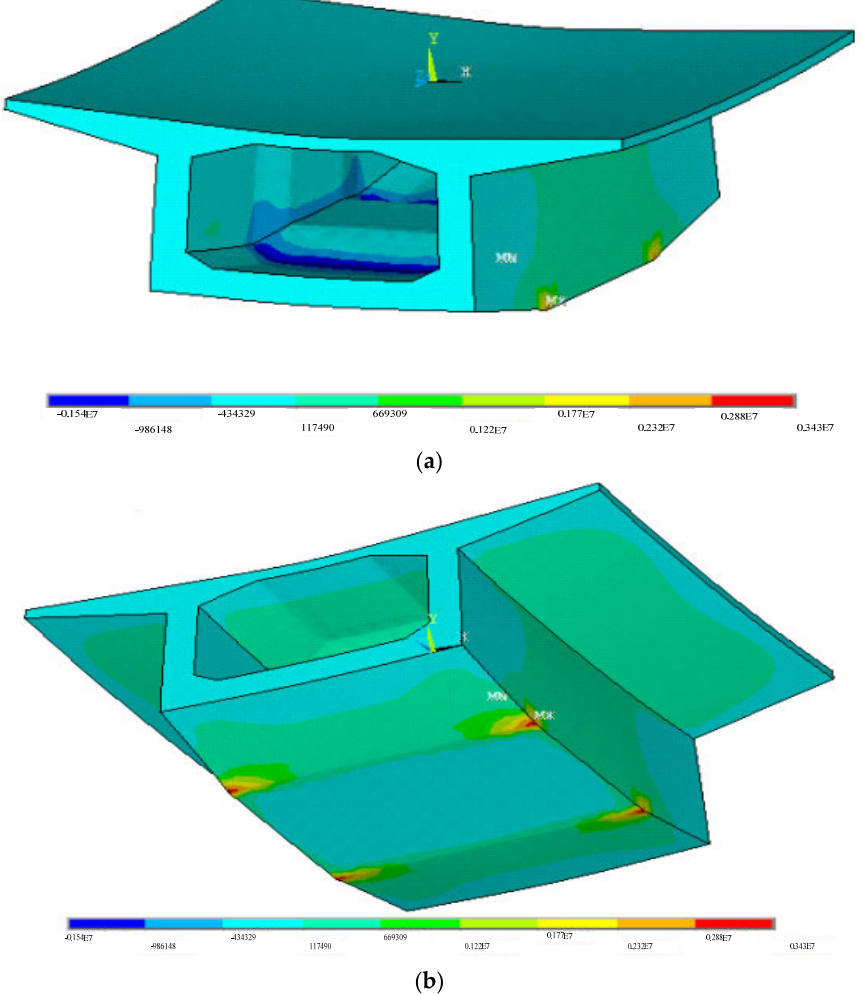
Figure 6. Calculated thermal stress field on the 0-block (Unit: Pa). ( a ) View from the top; ( b ) view from the bottom. Table 1. Samples based on one ‐ factor design.